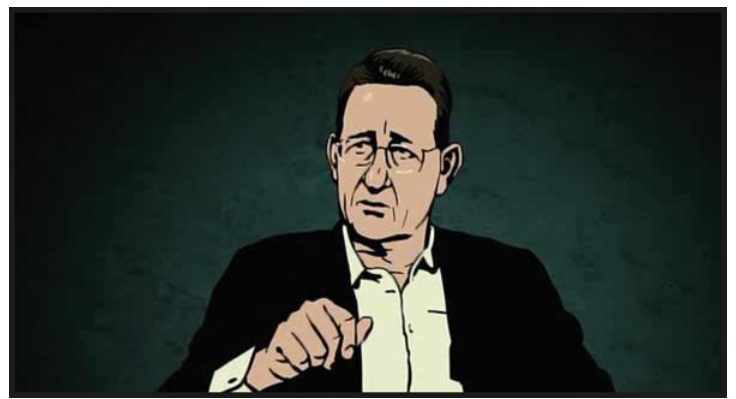
Image1: Waltz with Bashir